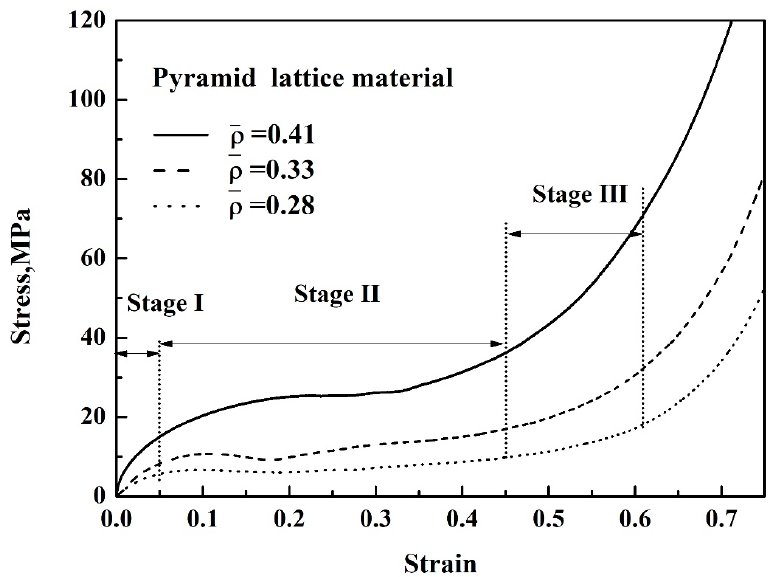
Figure 3. Stress–strain curves of the pyramid lattice material with different relative densities.